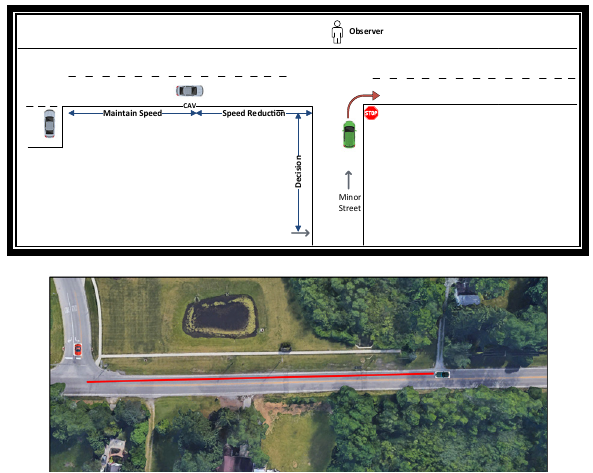
Figure 16: Setup for fi eld